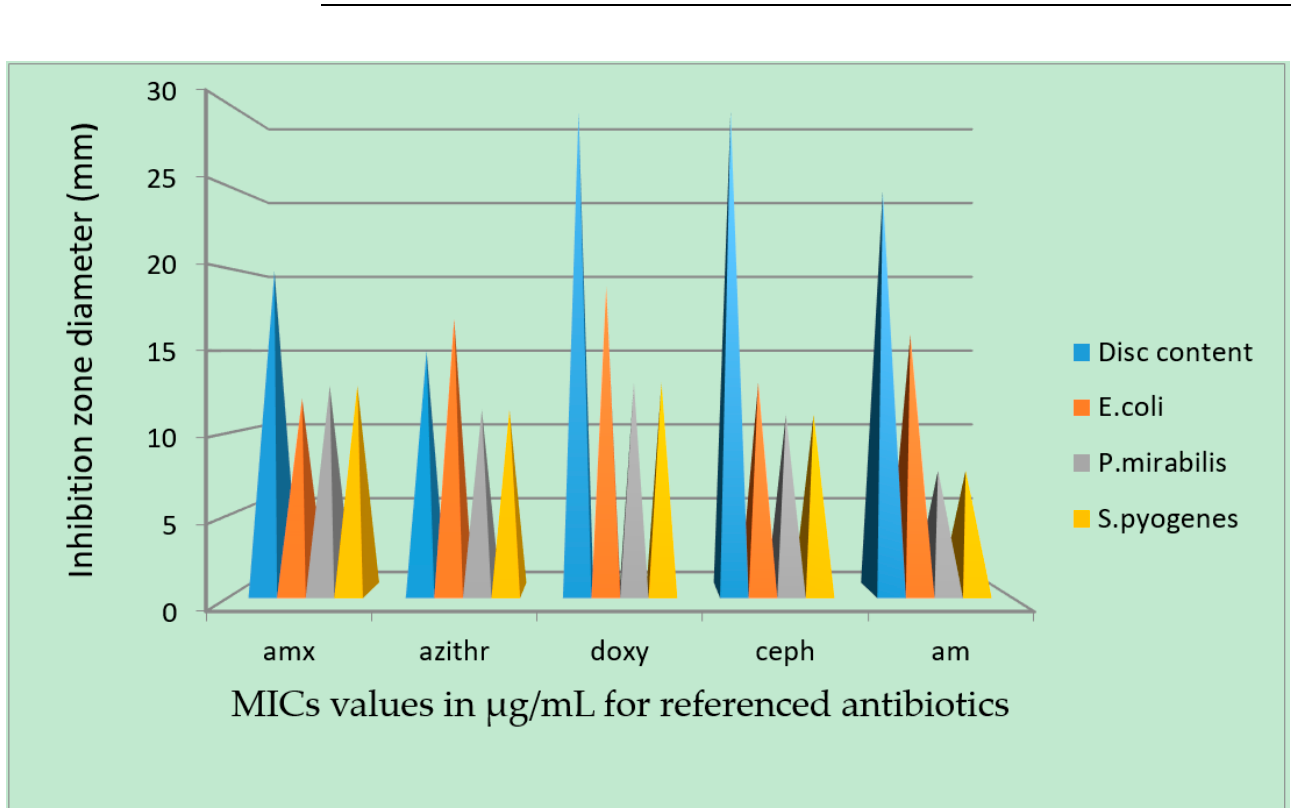
Figure 6. Antibacterial susceptibility of some species bacteria given as MICs values in µg/mL for referenced antibiotics. Table 3. Inhibition zone diameters (mm) of reference antibiotics and synthesized compounds 22